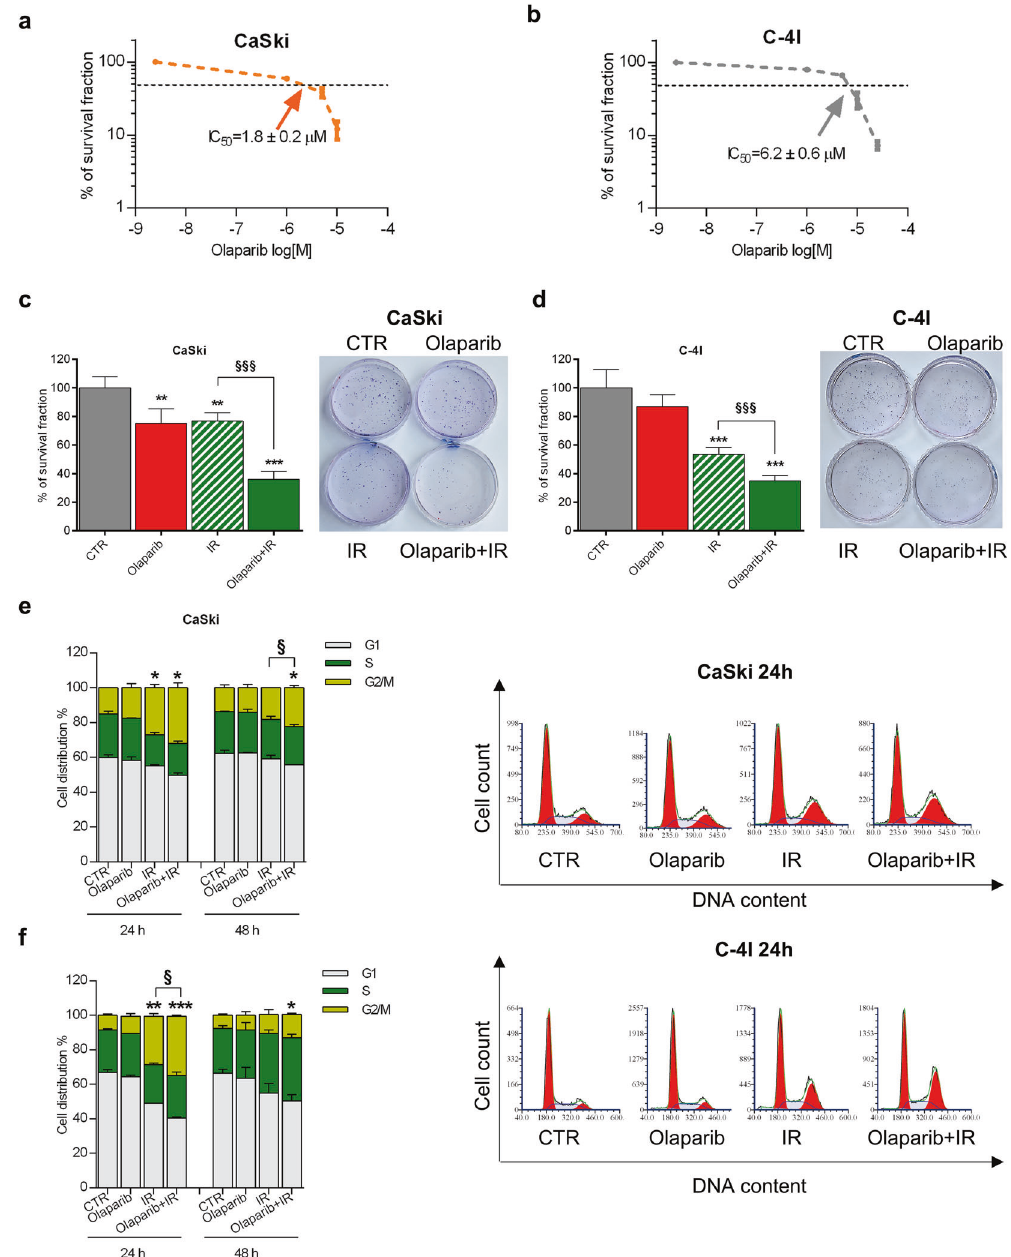
Fig. 3 Olaparib sensitizes radioresistant cervical cancer cells. Clonogenic survival of CaSki ( a ) and C-4I ( b ) cells treated with Olaparib. Arrows indicate the IC50 value for each cell line (mean ± SEM). Clonogenic survival fractions of CaSki ( c ) and C-4I ( d ) cells treated with Olaparib with or without IR (2 Gy). For the combined treatments, the Olaparib dose that inhibited 30% of the colony-forming ability of CaSki (IC30, 0.7 µM) was added to the plates 1 h prior to gamma-irradiation. Cells were pretreated for 1 h with Olaparib and then irradiated. Bar charts represent the percentage of survival fraction normalized to CTR (mean ± SD, n = 4) and representative pictures are shown. Statistical signi fi cances have been evaluated through an unpaired t -test. ** P < 0.01 and *** P < 0.001 respect to CTR. §§§ P < 0.001 combined treatment with respect to IR. Stacked percentages of CaSki ( e ) and C-4I ( f ) cells in the G1, S, and G2/M cell cycle phases after 24 and 48h treatment of Olaparib (0.7µM) with or without IR (2 Gy) (mean ± SD, n = 2). Cells were pretreated for 1 h with Olaparib and then irradiated. Representative plots of cell cycle analysis after 24h of treatment are shown for each cell line. Statistical signi fi cances have been evaluated only for the G2/M phases through an unpaired t -test. * P < 0.05, ** P < 0.01, and *** P < 0.001 respect to untreated cells (CTR). § P < 0.05 combined treatment with respect to IR. CTR untreated. IR: 2 Gy γ